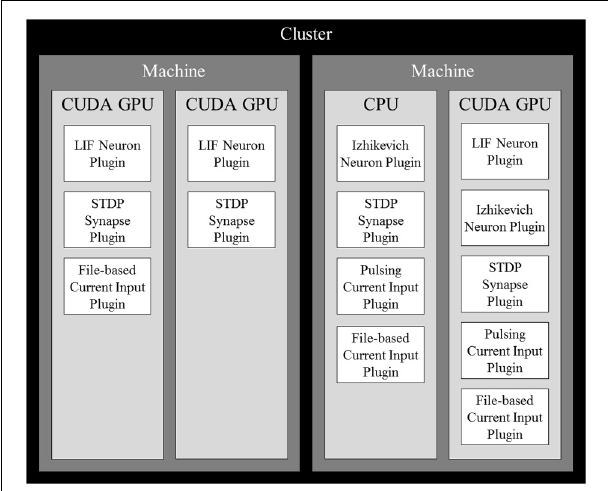
FIGURE 1 | An example of a complete distribution of simulation elements in NCS6. Elements are distributed across devices based on the devices’ computational power and their dependencies. Synapses and inputs associated with a particular neuron are linked to it on a device. Within devices, elements are organized into contiguous sections by type that are simulated by plugins of their specific type.